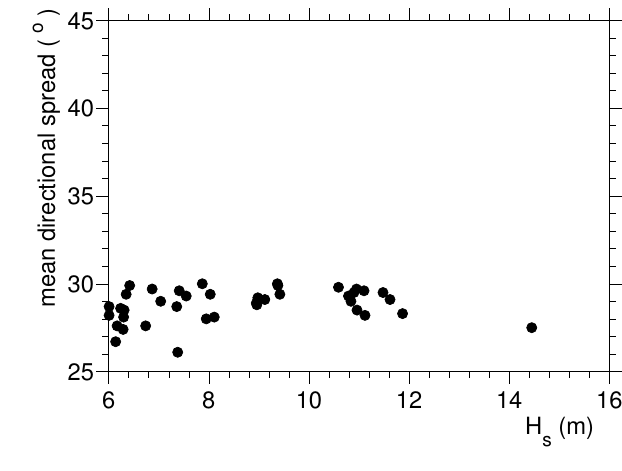
Fig. 3. JONSWAP γ -like parameter as a function of k p H s / 2 for swells (Oceanweather Inc. hindcast).